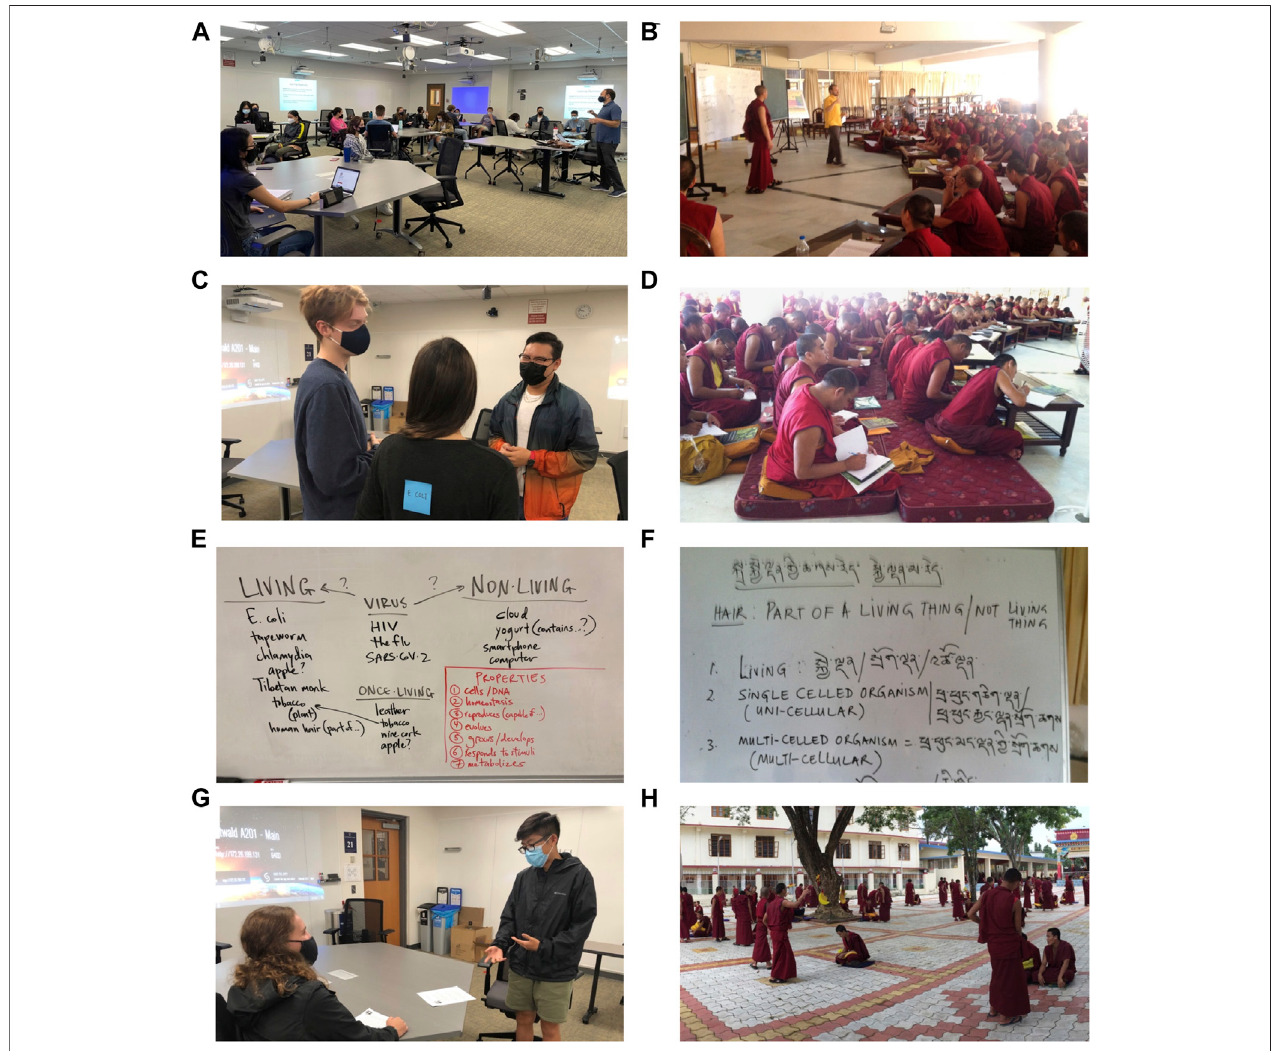
FIGURE 1 | Comparing the undergraduate PUI teaching experience to teaching monks. A typical classroom at the University of Richmond (A) compared with a typical classroom at the Sera Jey monastery in Bangalore, India (B) . Smaller classroom sizes allow for active participation in determining “ what is life ” (C, E) but similar learning objectives can be achieved through large lecture techniques (D, F) . Debate can be incorporated into the undergraduate classroom (G) and is essential to monastic learning (H) . Written informed consent was obtained from the individuals for the publication of identi fi able images.